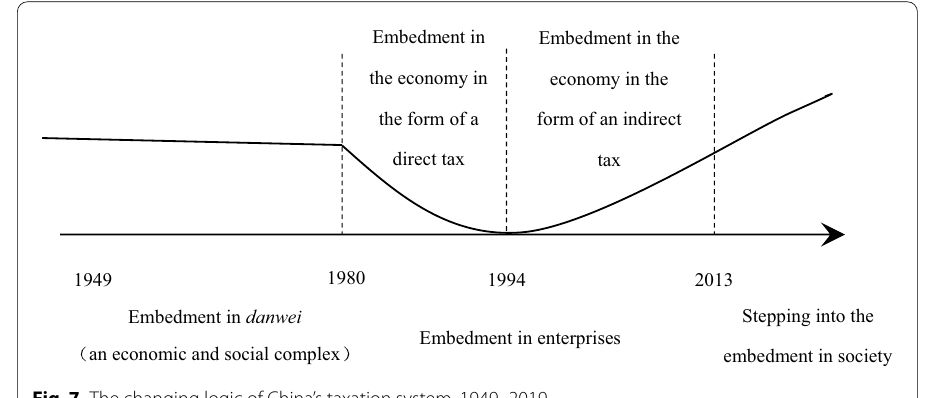
Fig. 7 The changing logic of China’s taxation system,